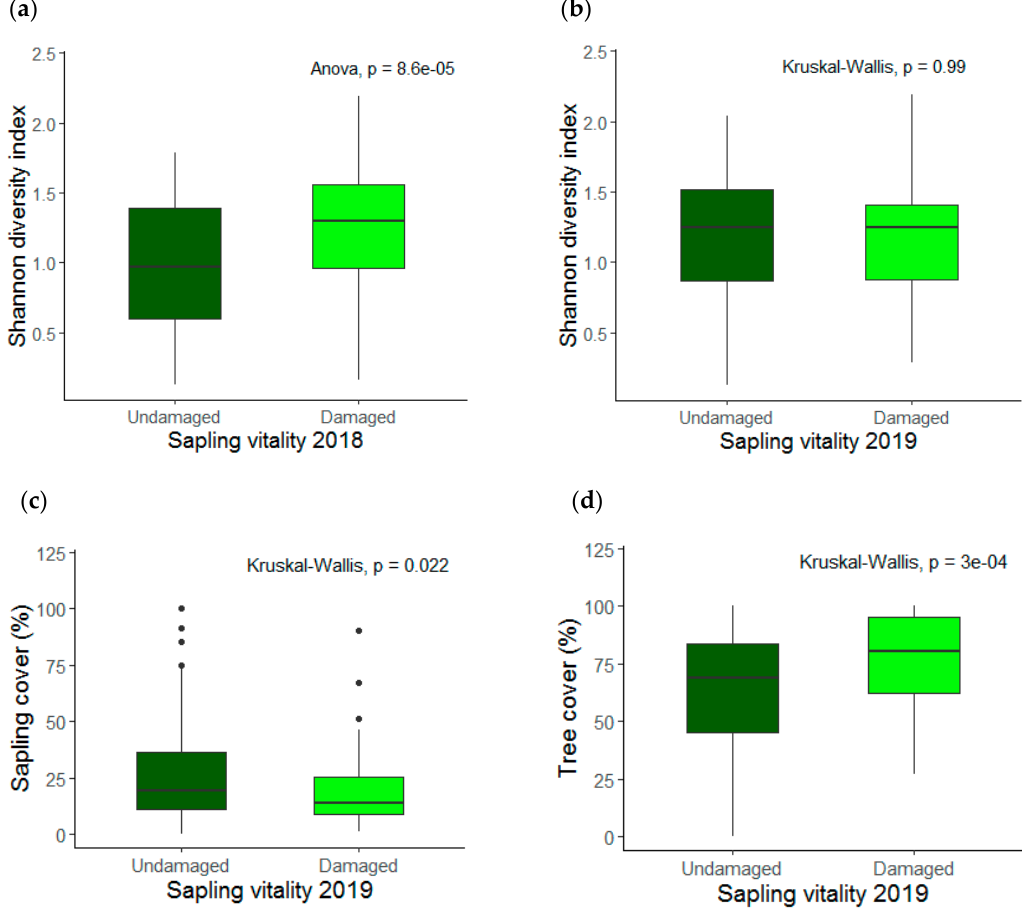
Figure 5. Shannon diversity index for all tree species and sapling vitality per plot in 2018 ( a ) and 2019 ( b ). ( c ) Sapling vitality and sapling cover (%); ( d ) Sapling vitality and mature tree cover (%). ( a ) The 53 plots undamaged and 160 damaged in 2018; ( b – d ) The 159 plots with saplings undamaged and 54 plots with saplings damaged in 2019.